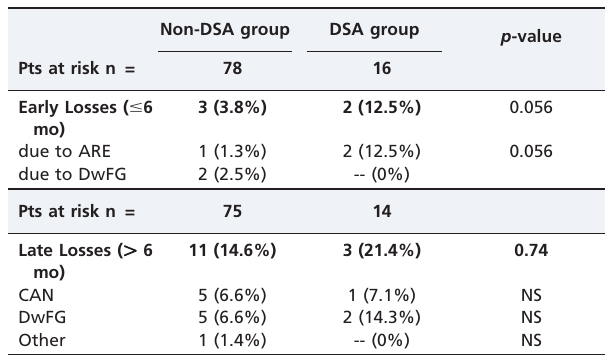
Table 3 - Causes of graft loss and death with a functioning graft prior to 6 months and at the final follow-up visit post-Tx.